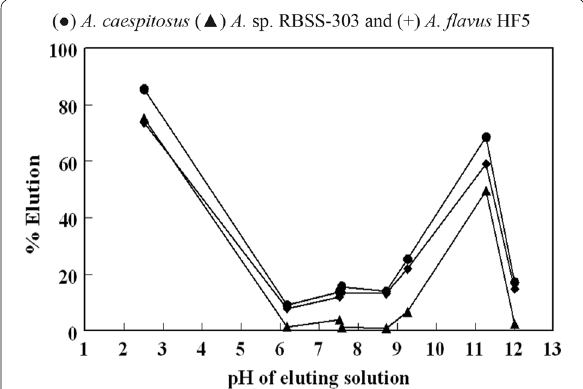
Fig. 8 Effect of pH of desorbing agents on elution of lead from Pb(II) loaded biomass A. sp. RBSS-303, A. caespitosus and A. flavus HF5 (0.025 g dry weight of metal laden biomass was shaken for 1 h with 30 mL of eluent at 180 rpm and 28 2 °C) ±